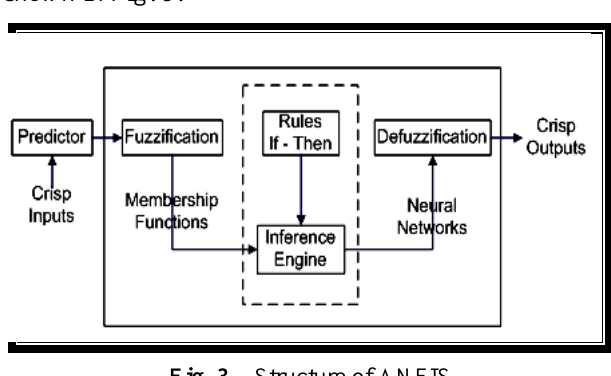
Fig. 3 . Structure of